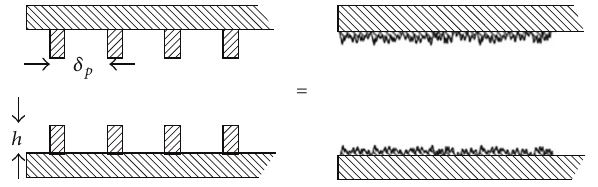
Figure 8: Schematic view of DDT obstacle layout